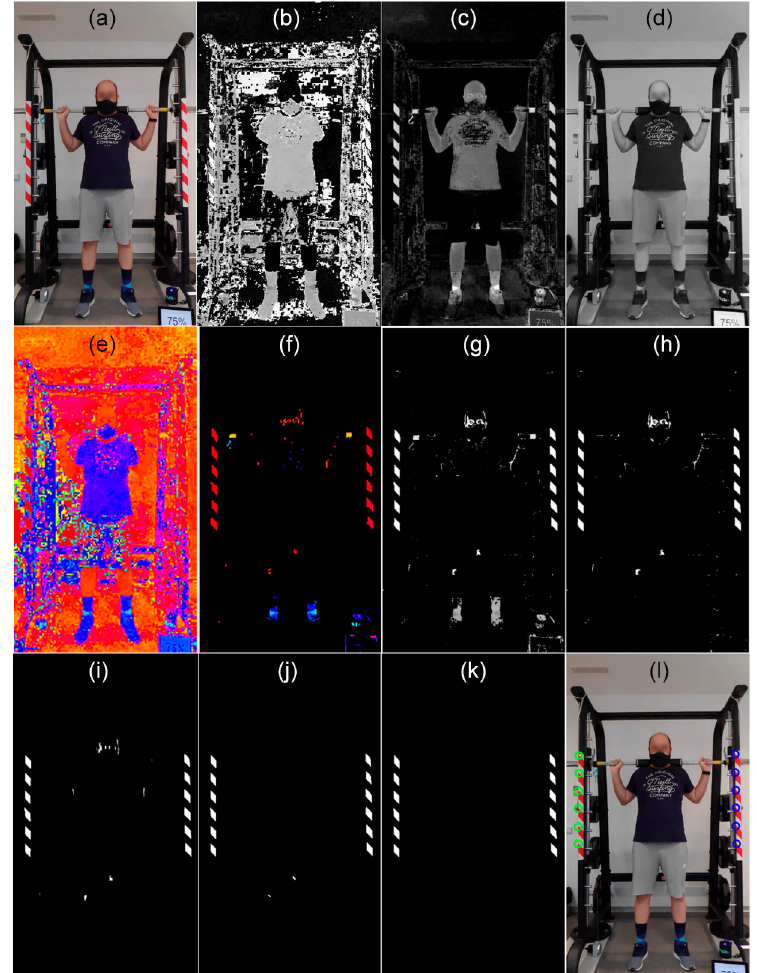
Figure 4. Automatic detection of reference points in the multipower machine. ( a ) Original image. ( b ) Hue, ( c ) saturation, and ( d ) value components of original image. ( e ) Same image as ( b ) but the representation of each value is in colors according to the palette hsv ( f ) Same image as ( e ) but all pixels with saturation lower than 0.5 are set to black. ( g ) DifHue , taking as target the hue corresponding to the color red RGB (1, 0, 0). ( h ) Binarized image ( g ). ( i ) Output of the vertical tophat bandpass filter. ( j ) Output of the inclined tophat bandpass filter. ( k ) Filtered image. ( l ) Detected strip points and barbell position.